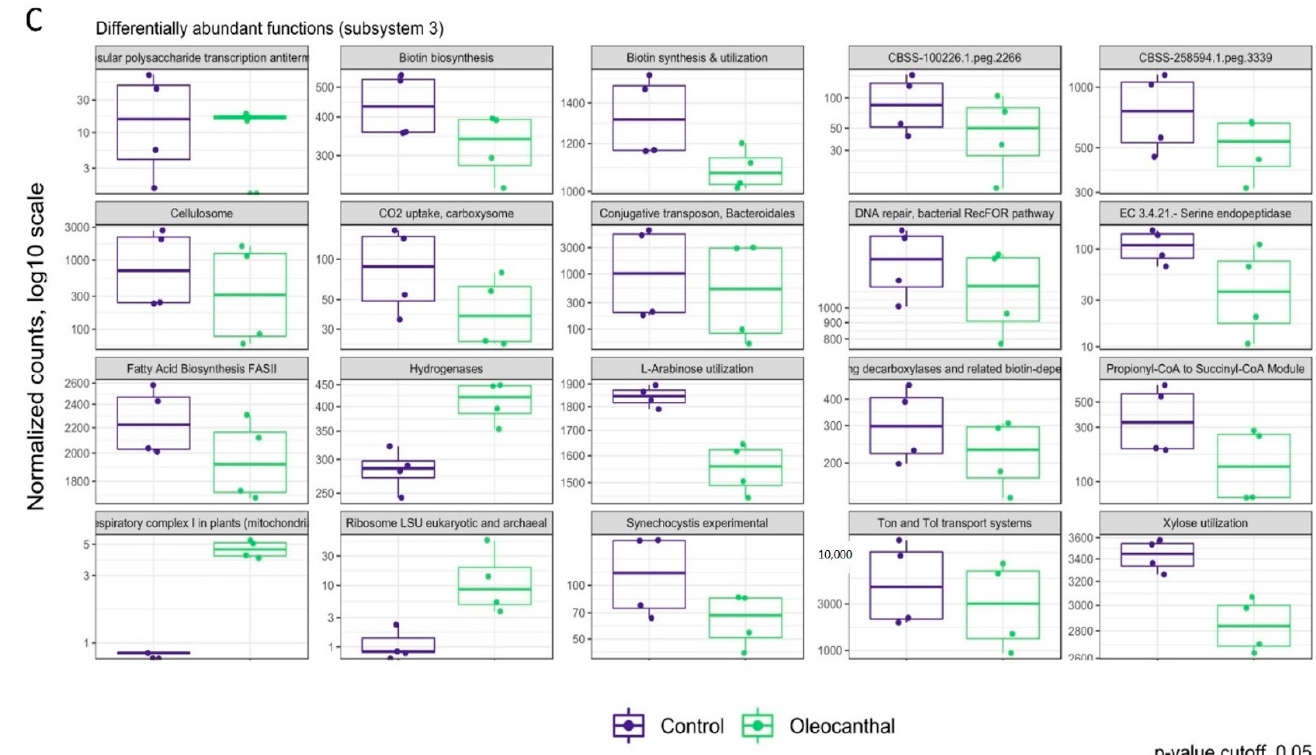
Figure 6. Differential abundance testing of bacterial taxonomy. ( A ) The ten topmost upregulated and downregulated taxa by OC treatments identified by differential abundance analysis using negative binomial models (DESEq2 R package) within the shotgun data after controlling for mouse species and sex differences. The analysis was obtained for NS media samples only; p -value cutoff = 0.1. ( B ) The linear models of operational taxonomic units, obtained using the DESEq2 R package, profiling the topmost OC-affected taxa at the species level as compared to the pertinent control in NS medium. Bacteria downregulated by OC treatments are displayed in red, while upregulated bacteria are displayed in green. ( C ) Differential abundance testing of subsystem level 3 functions. The most-regulated plausible physiological functions for GM species affected by OC were identified by differential abundance analysis using negative binomial models (DESEq2 R package) within the shotgun data, after controlling for mouse species and sex differences. The analysis was obtained for NS media only. p -Value cutoff =